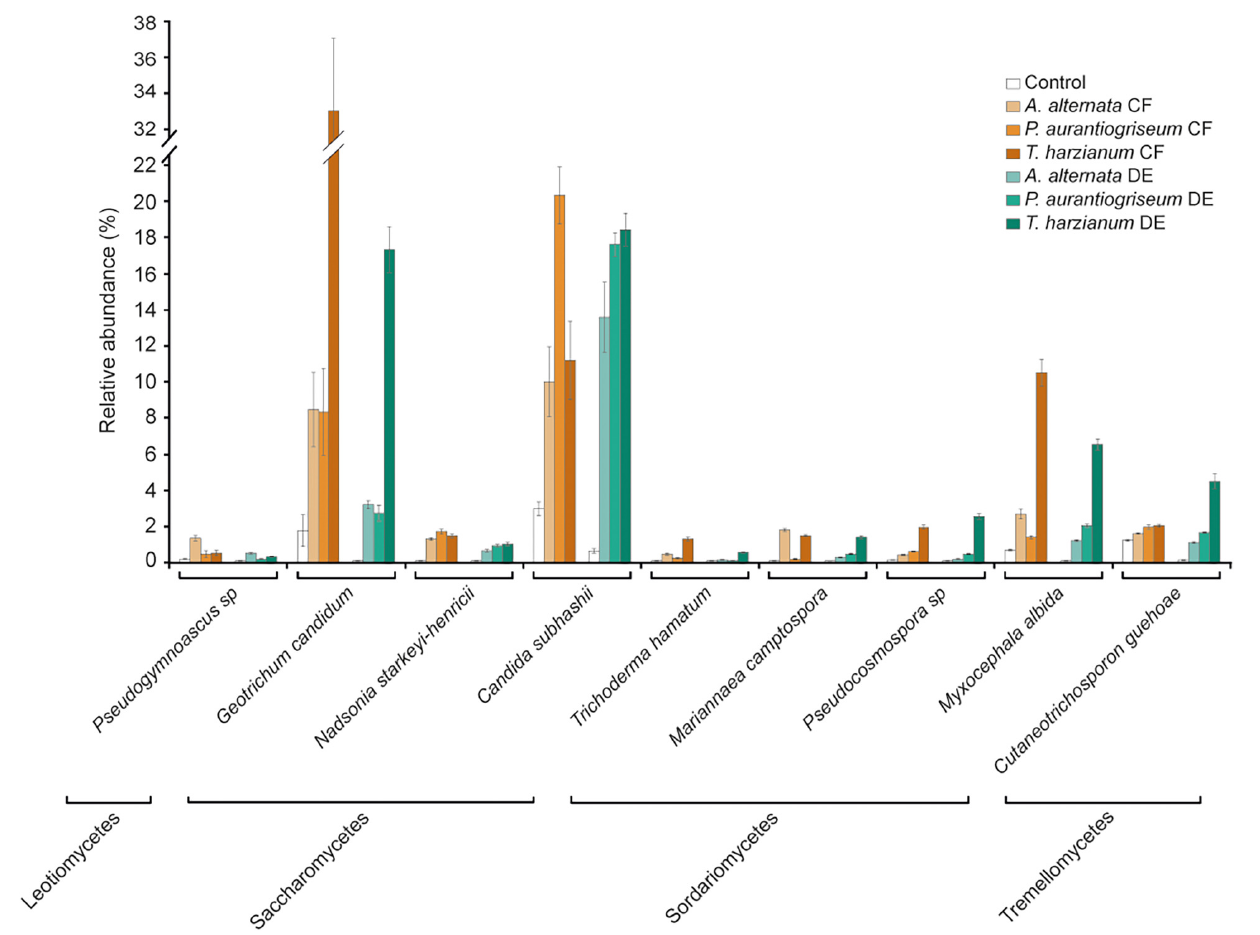
FIGURE 8 | Soil application of fungal CFs and DEs strongly enriches the same beneficial soil fungal species. The figure shows the relative abundances of fungal species in soil discussed here that were significantly up-regulated by soil application of fungal CFs (highlighted in brown) and DEs (highlighted in green) according to a Student’s t -test ( P < 0.05). Values represent the mean ± SD. Relative abundances of fungi in control soils are shown in white bars. Data obtained from Supplementary Table 4